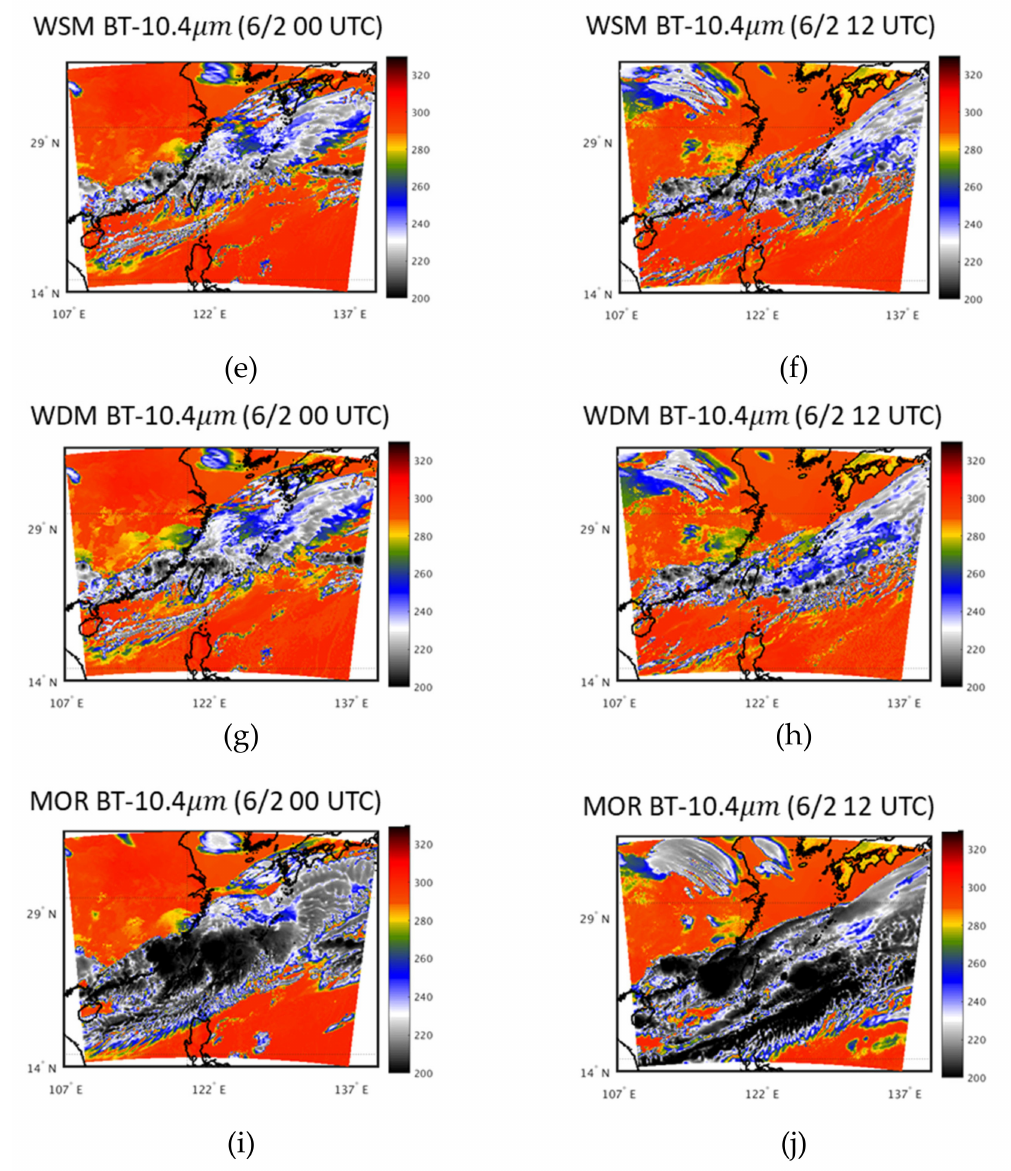
Figure 6. The observed ( a , b ) and simulated ( c – j ) BT on 2 June 2017 at 0000 and 1200